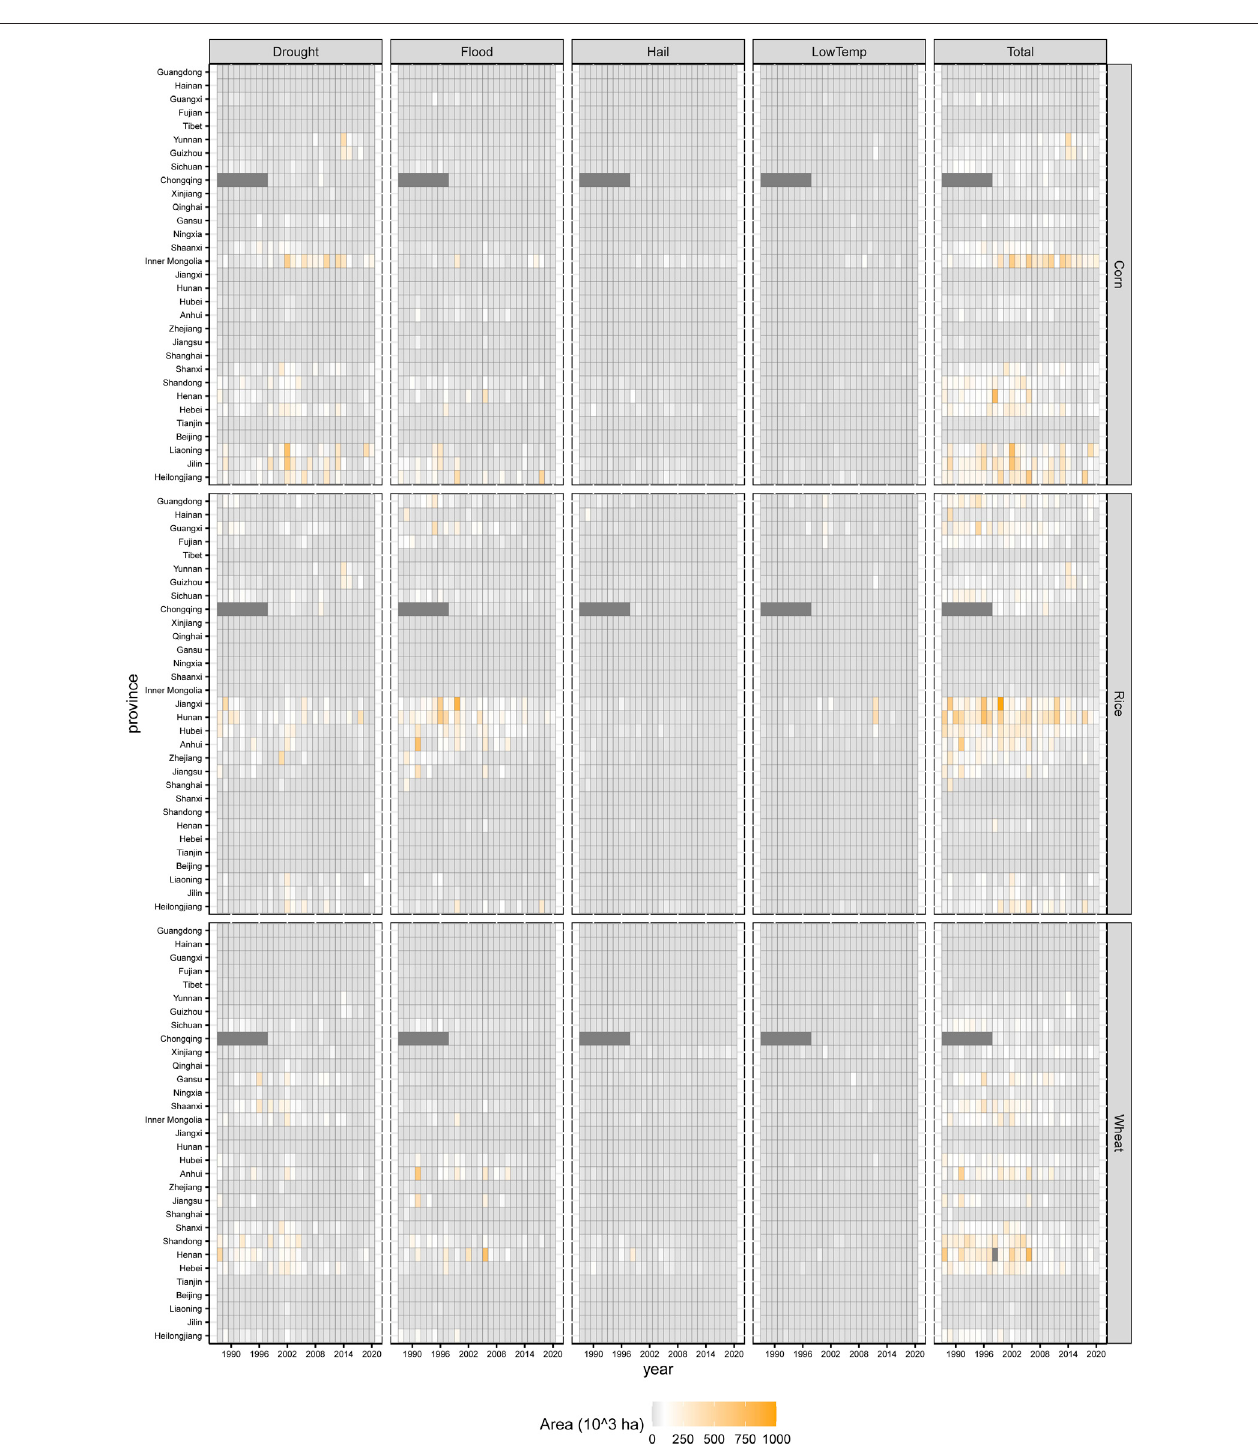
FIGURE 7 | Changes in the area affected by different severe natural disasters for rice, maize, and wheat in each province from 1988 to 2020.